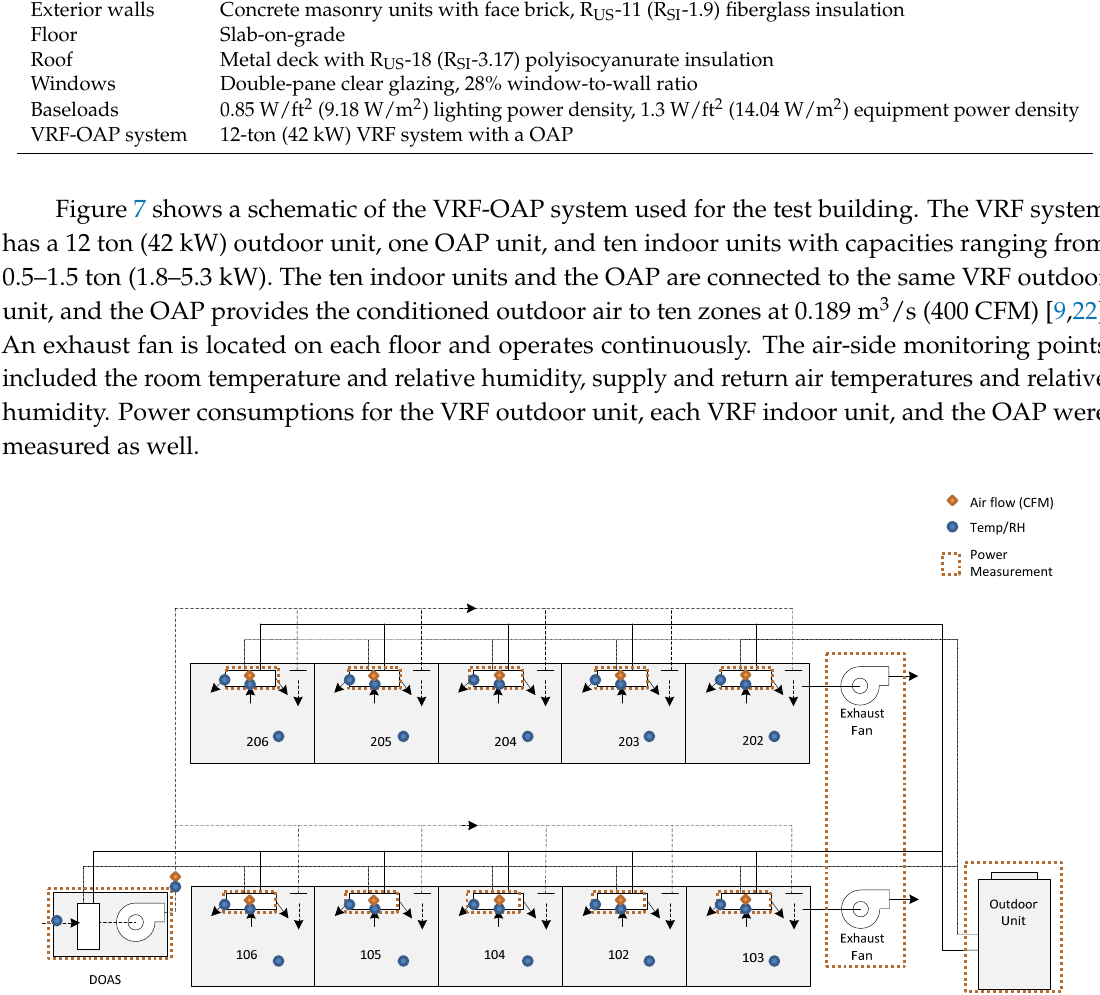
Figure 7. System schematic and monitoring points for VRF ‐ OAP system.